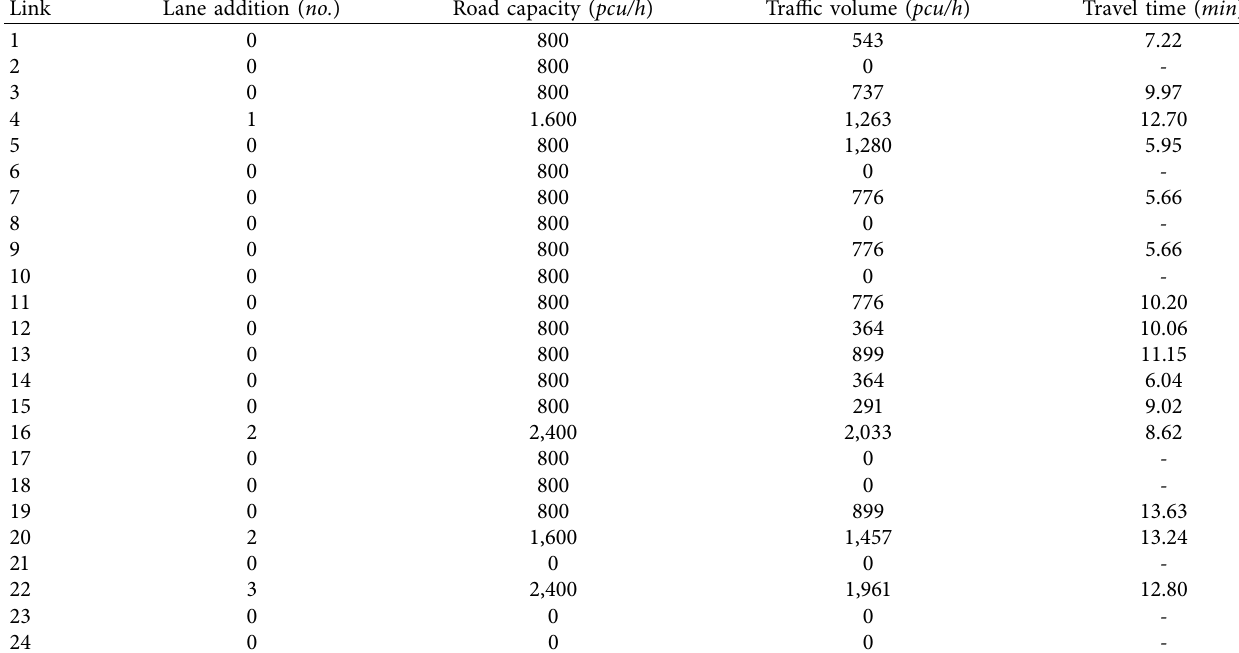
Table 3: The optimal network design and link performances.